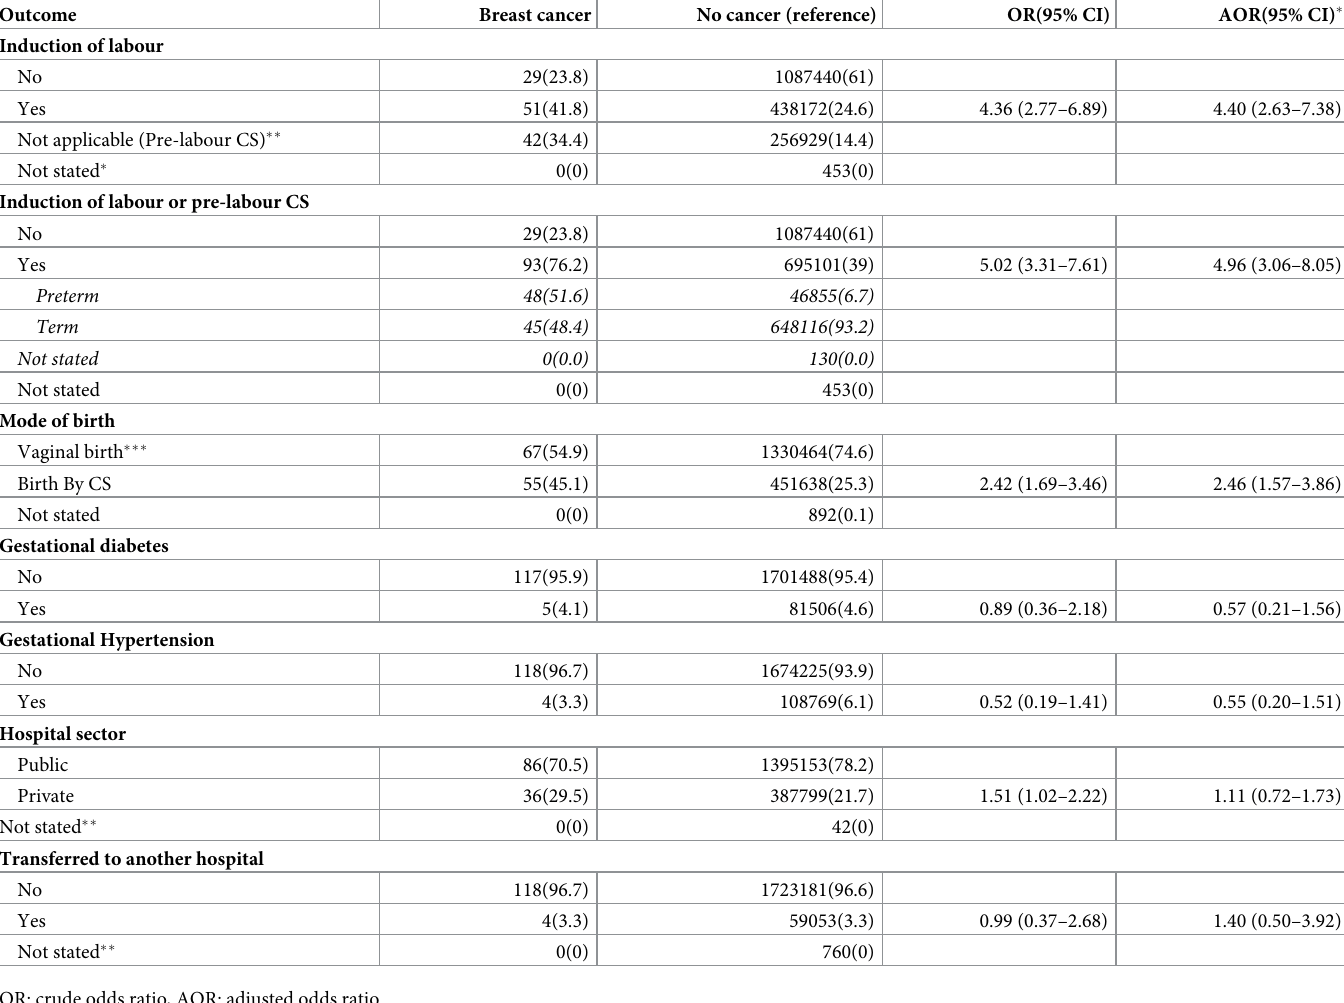
Table 2. Obstetric management and pregnancy complications by cancer